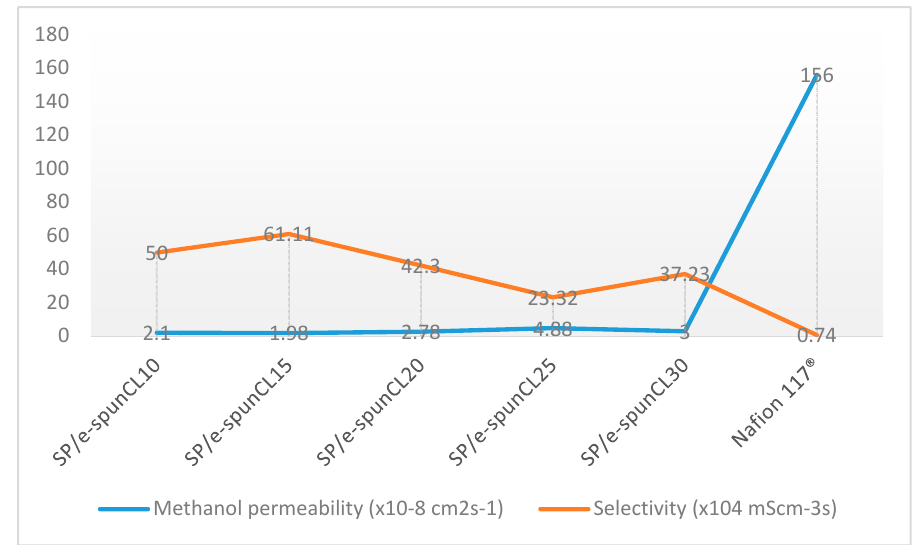
Figure 6. Methanol permeability of Nafion117 ® and all membrane samples at room temperature.